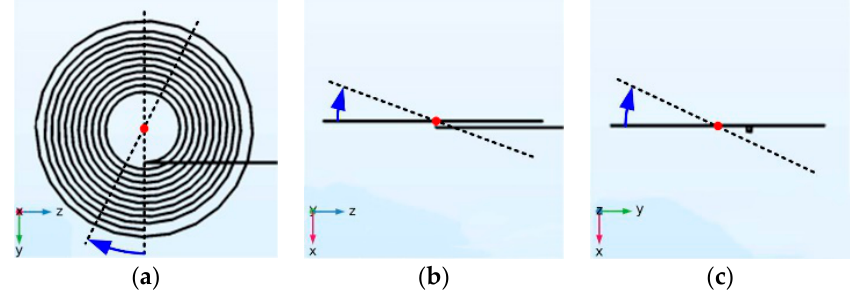
Figure 4. Rotating axes of receivers for ( a ) x -axis, ( b ) y -axis and ( c ) z -axis.